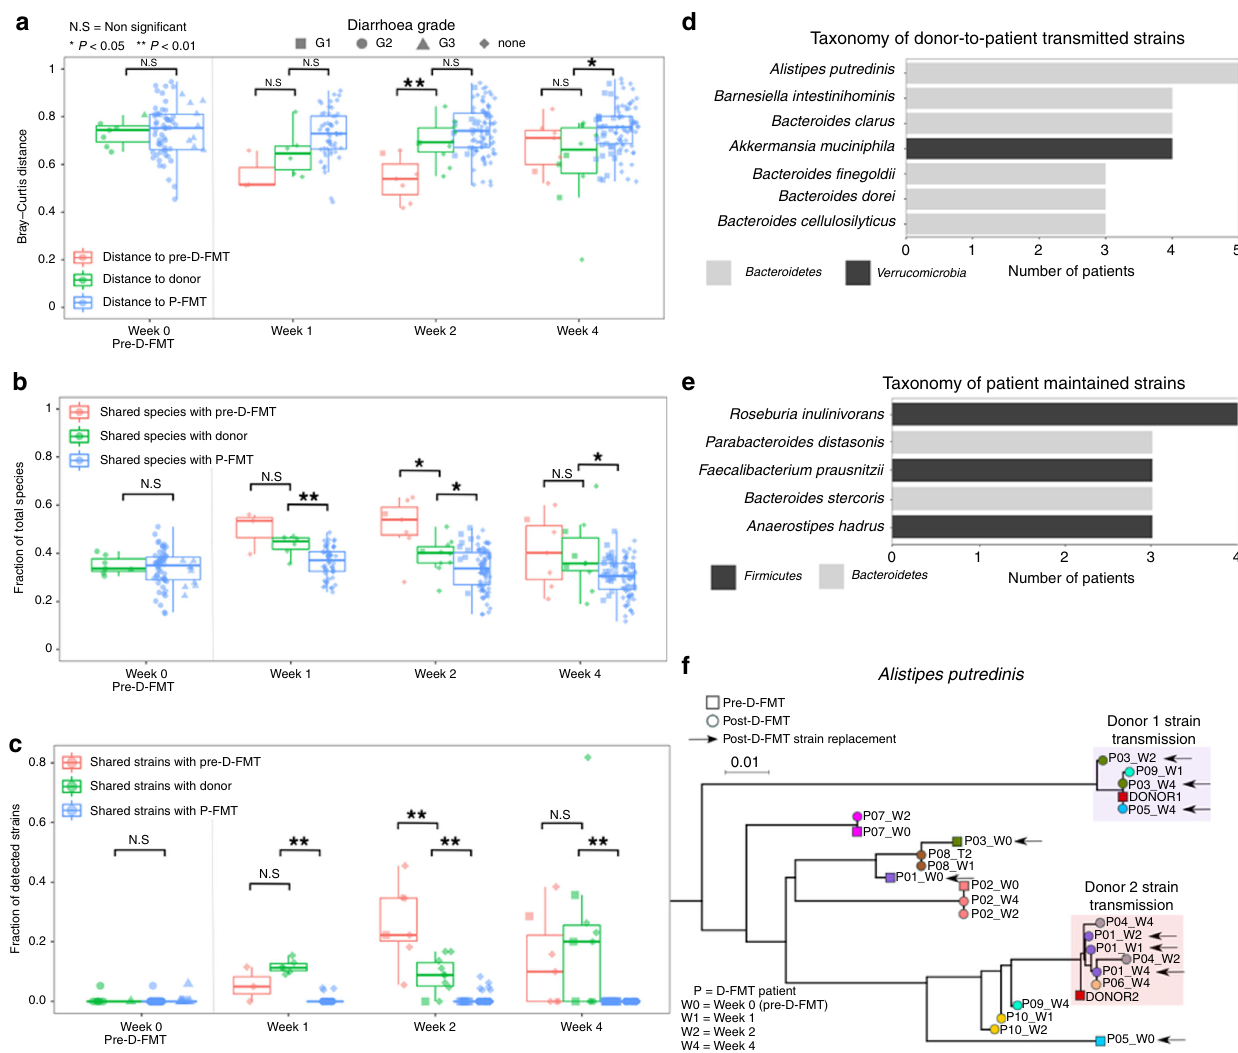
Fig. 2 Long-term donor microbial strain engraftment in mRCC patients receiving D-FMT. We evaluated the effect of D-FMT in patients by assessing how much the overall microbiome got closer to that of the donor after FMT using a pairwise Bray-Curtis distances calculated on species-level abundances ( p values from left to right: p = 0.74, p = 0.17, p = 0.06, p = 0.004, p = 0.177, p = 0.74 and p = 0.013), b the fraction of shared species ( p values from left to right: p = 0.724, p = 0.381, p = 0.007, p = 0.018, p = 0.047, p = 0.889 and p = 0.04), and c strains between pairs of samples (see Methods) ( p values from left to right: p = 0.18, p = 0.262, p = 1.5 × 10 − 10 , p = 0.007, p = 2.8 × 10 − 11 , p = 0.723 and p = 5.36 × 10 − 14 ). All p values were calculated using a two- sided Wilcoxon rank-sum test. While all patients had a microbiome as distinct from the donors as control patients, after D-FMT the donor-recipient microbiome distance was reduced with signi fi cantly more species and strains shared. The donor ’ s strains remained in the recipient for up to 30 days, highlighting the high engraftment potential of a single D-FMT treatment in the patients. Box-plots report median (central lines), 25th and 75th percentiles (box limits), and the upper and lower whiskers extend from the hinges to the largest (or smallest) value no further than ×1.5 interquartile range from the hinge, de fi ned as the distance between the 25th and 75th percentiles. d Species with the highest number of D-FMT patients showing evidence of acquisition of the donor ’ s strain and of e maintenance of pre-FMT strains. f Representative phylogenetic tree of Alistipes putredinis showing strain transmission and replacement events for this species between D-FMT patients and their respective